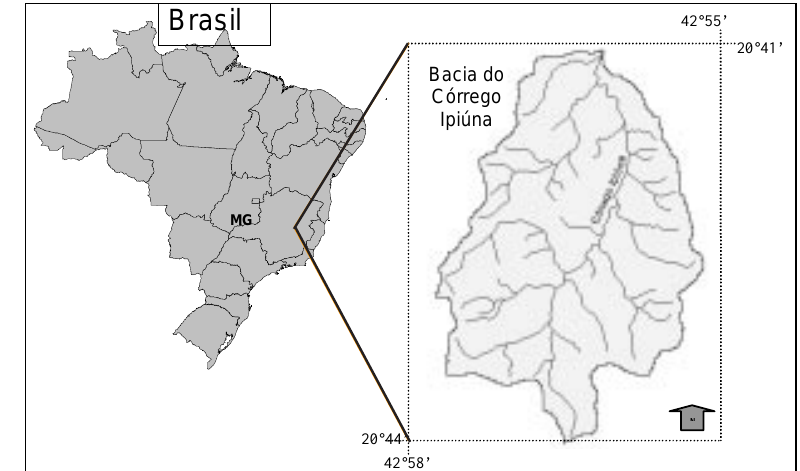
Figura 1. Esquema de localização da área de